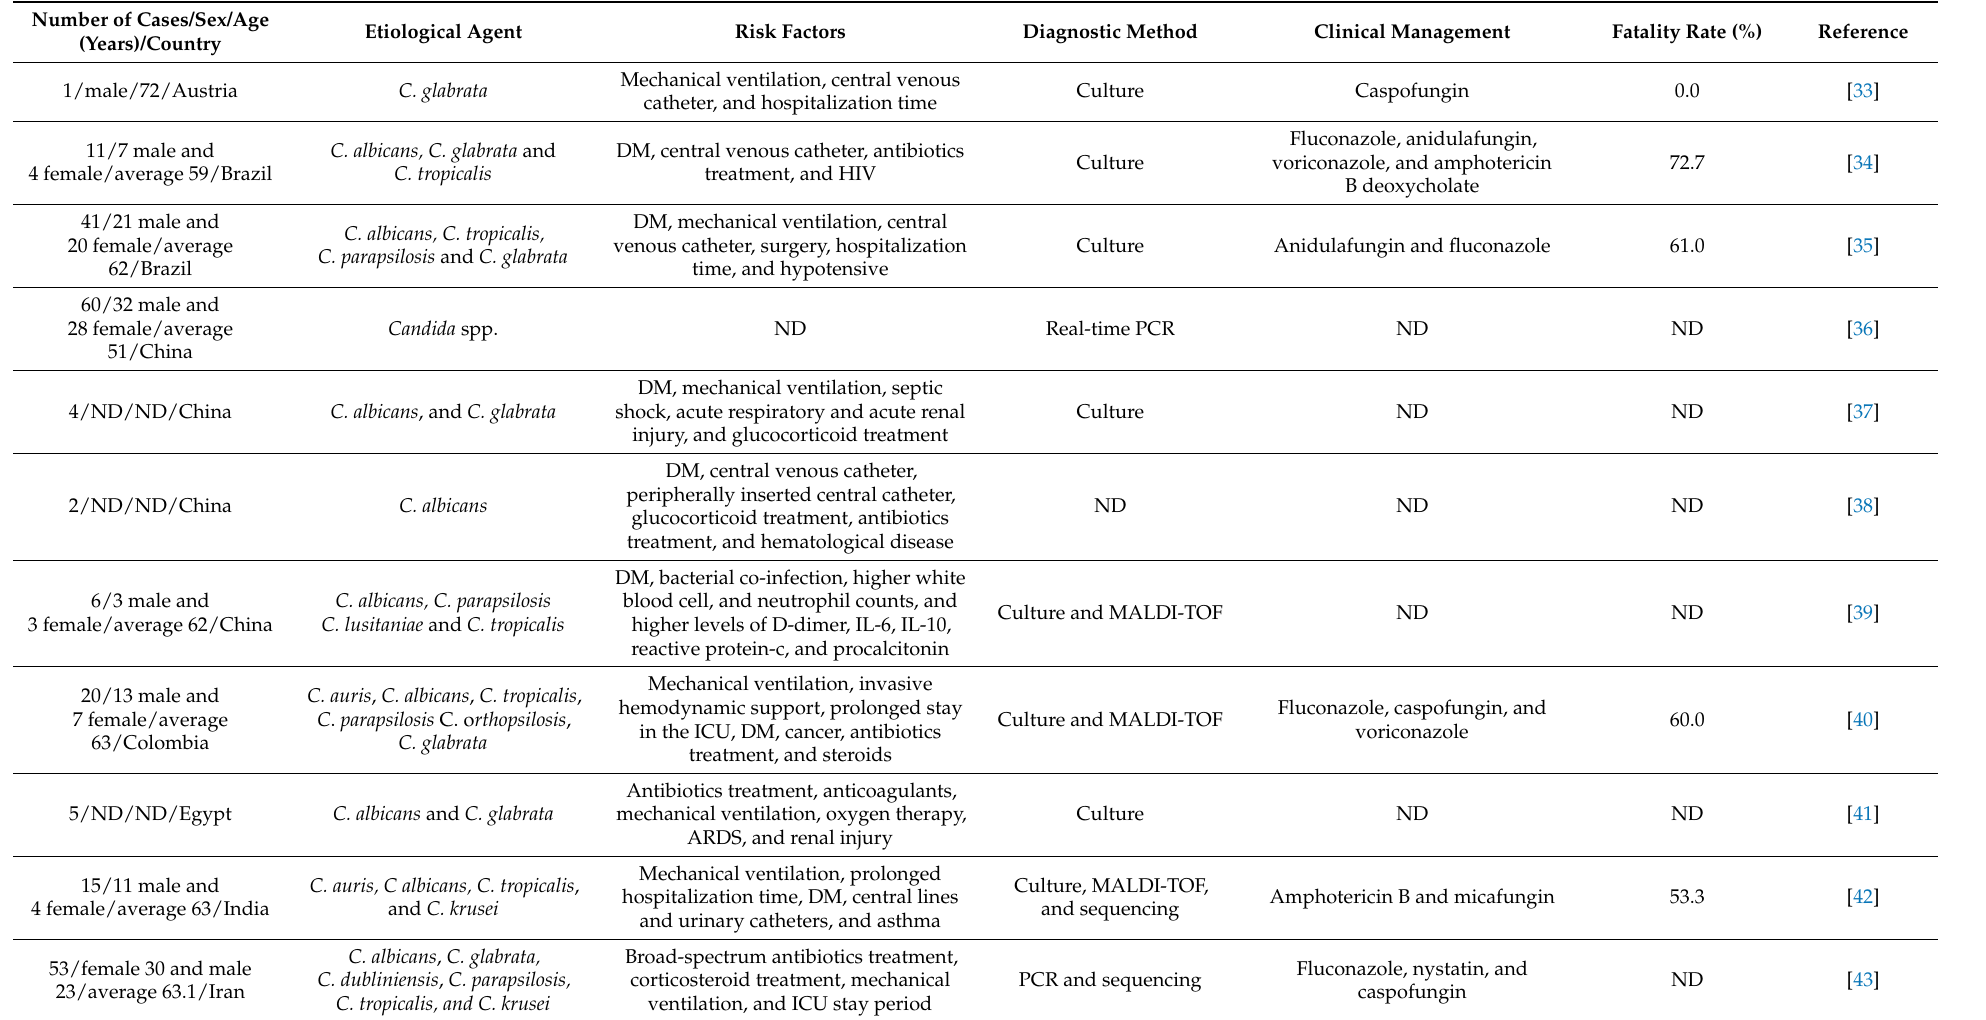
Table 2. Cases of COVID-19 and candidiasis